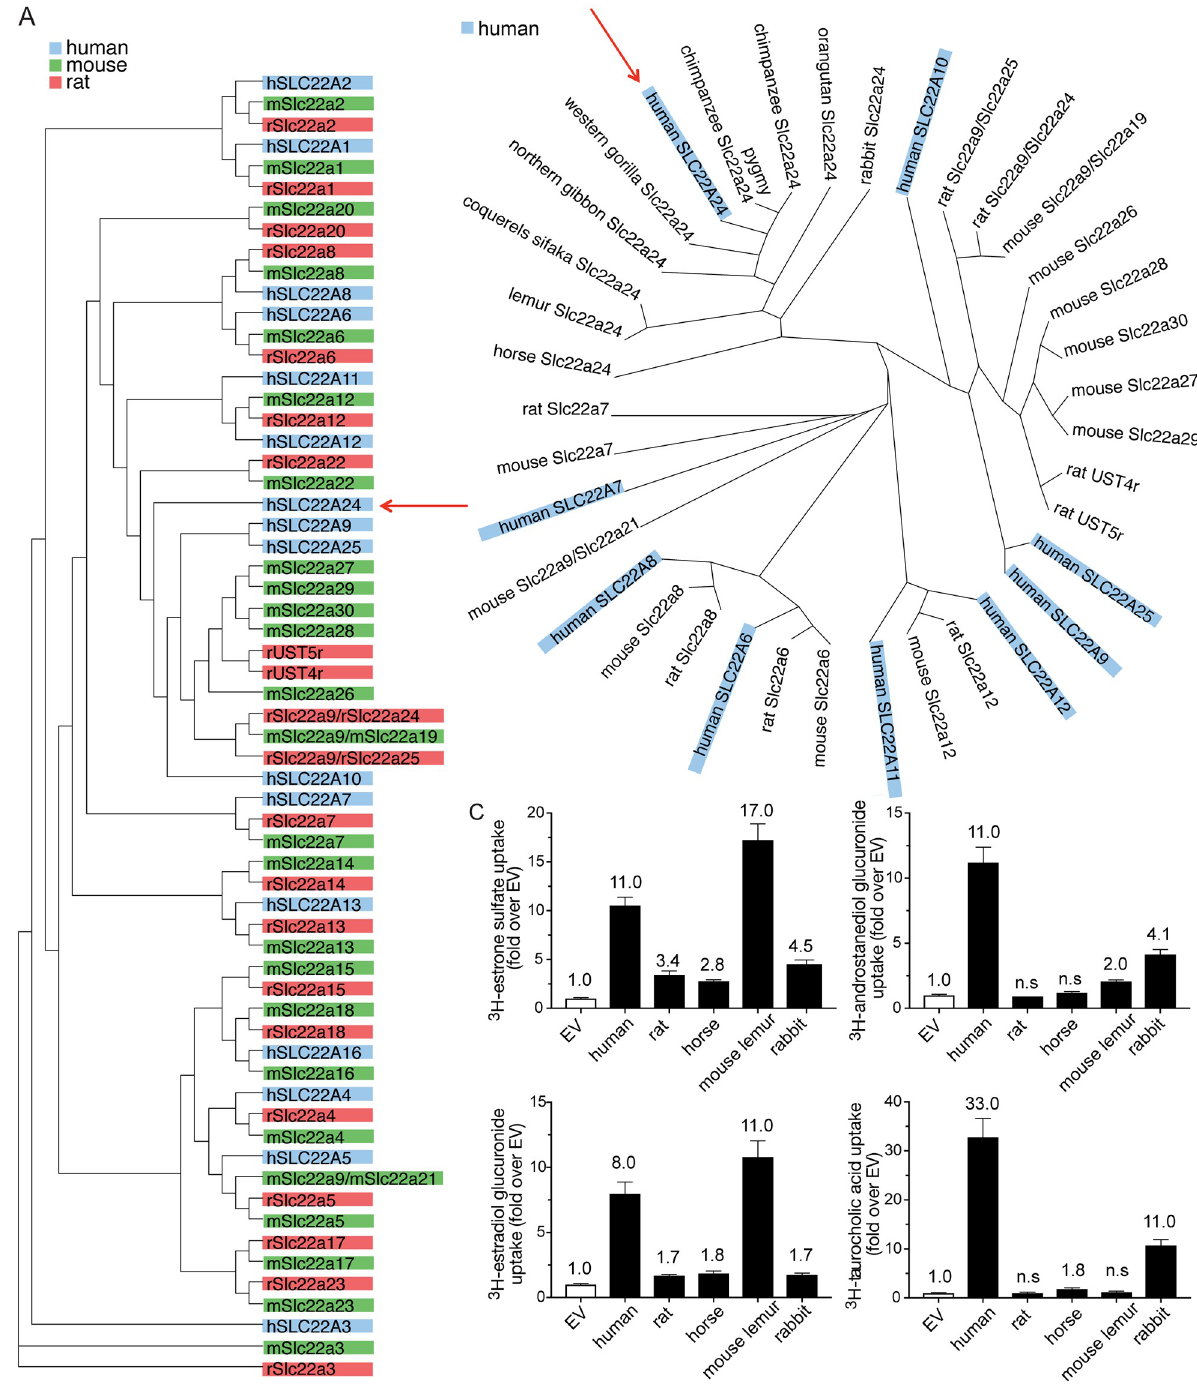
Fig 5. Phylogenetic tree analyses and uptake of anions by species orthologs of SLC22A24. (A) Sequence comparison of human, mouse, and rat protein sequences for all characterized SLC22 family members. Proteins are colored by organism. Red arrow points to the human SLC22A24. (B) Sequence comparison of characterized human anion transporters and select mammalian orthologs. Red arrow points to the human SLC22A24. (C) Fold uptake of four substrates by species orthologs of SLC22A24 and rat Slc22a9/Slc22a24 over empty vector control. Uptake of estrone sulfate, androstanediol glucuronide, estradiol glucuronide, and taurocholic acid was performed in HEK293 Flp-In cells transiently expressing SLC22A24 from human, mouse lemur, rabbit and horse or Slc22a9/a24 from rat. Uptakes were performed for 10 minutes. The number above the bar is fold uptake over EV cells from one experiment (mean ± S.D., from four replicate wells). The experiments were repeated one time and similar results were obtained. Underlying data are provided in S1 Data.